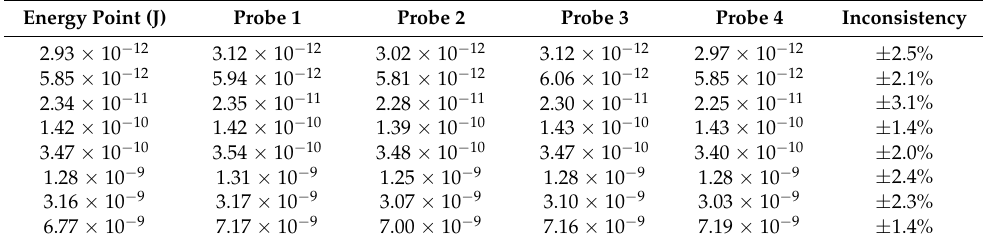
Table 1. A summary of the consistency of the four probe measurements.